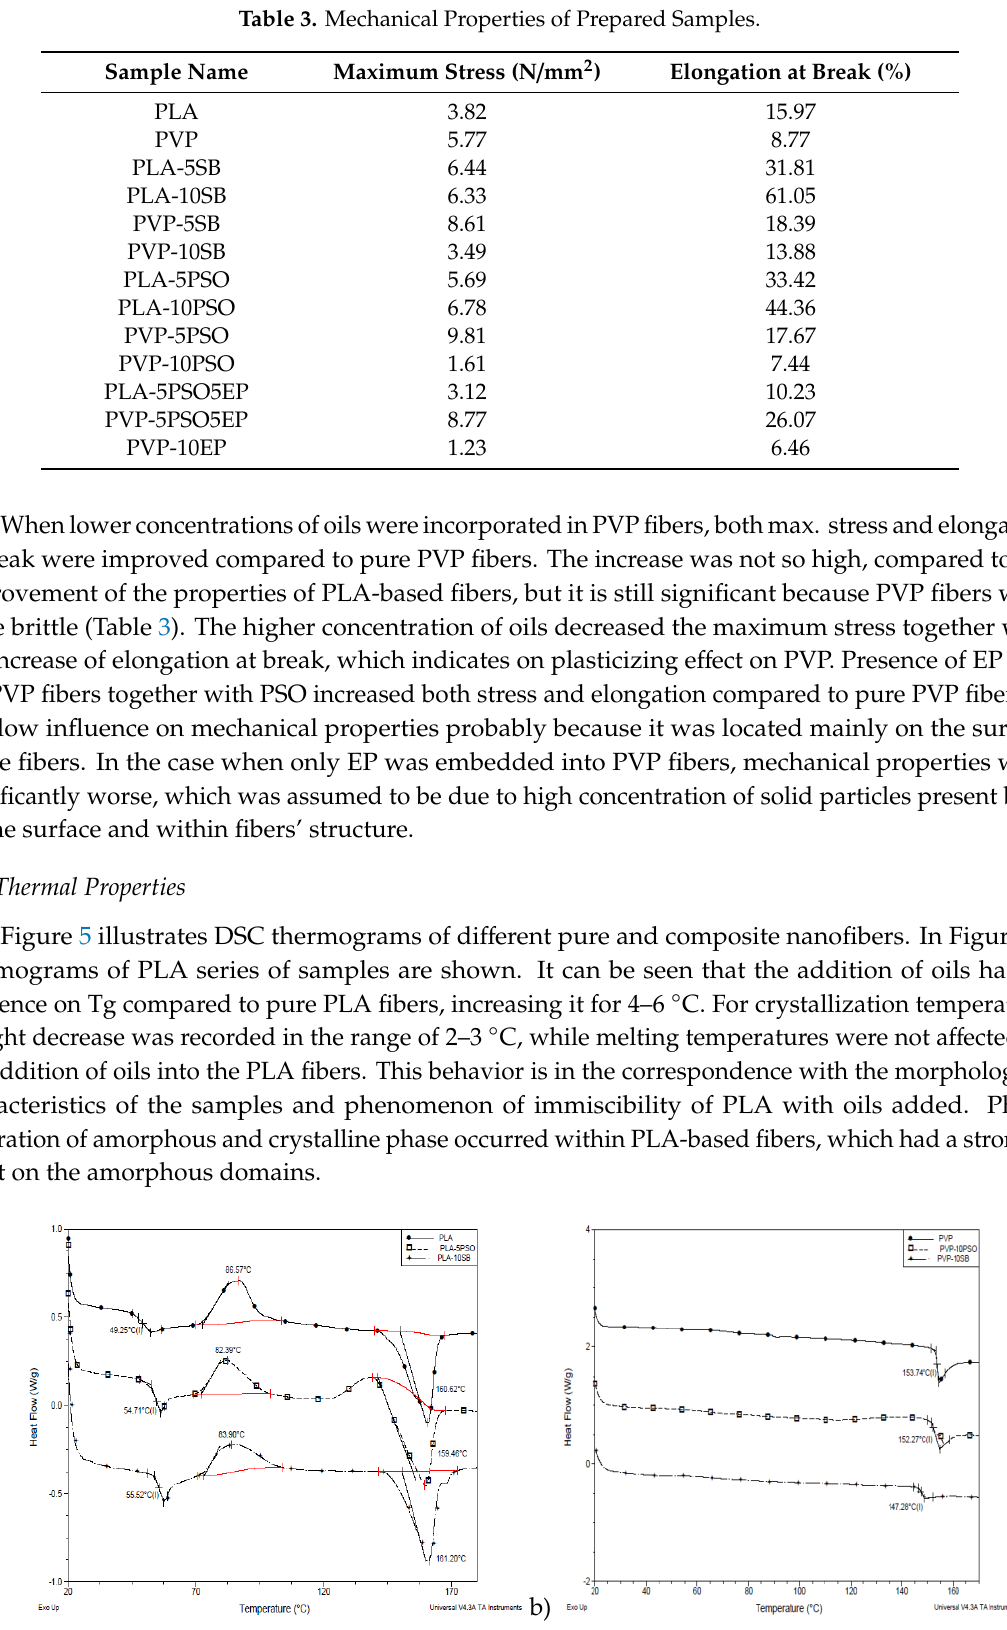
Figure 5. DSC thermograms of ( a ) PLA-based and ( b ) PVP-based series of samples.